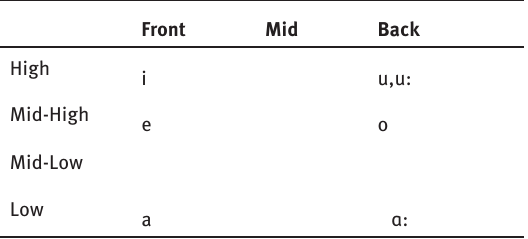
Table 2: Long and short vowels in Sabzevari are shown in the vowel chart below: